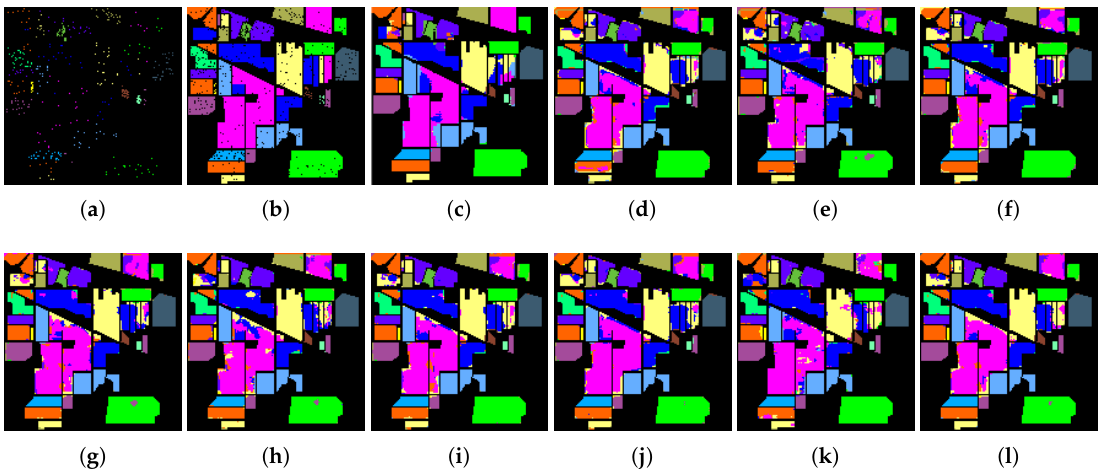
Figure 6. Classification maps of CNN and different DR models based on SVM on the Indian Pines data: ( a ) Training GT; ( b ) Testing GT; ( c ) CNN (OA = 89.1%); ( d ) SVM (OA = 86.0%); ( e ) SPPCA (OA = 83.5%); ( f ) NWFE (OA = 87.6%); ( g ) DGPLVM(OA = 88.5%); ( h ) SLGDA (OA = 89.4%); ( i ) LapCGDA (OA = 89.4%); ( j ) KCGDA (OA = 87.9%); ( k ) LGSFA (OA = 89.8%); and ( l ) GPGDA (OA = 91.7%).